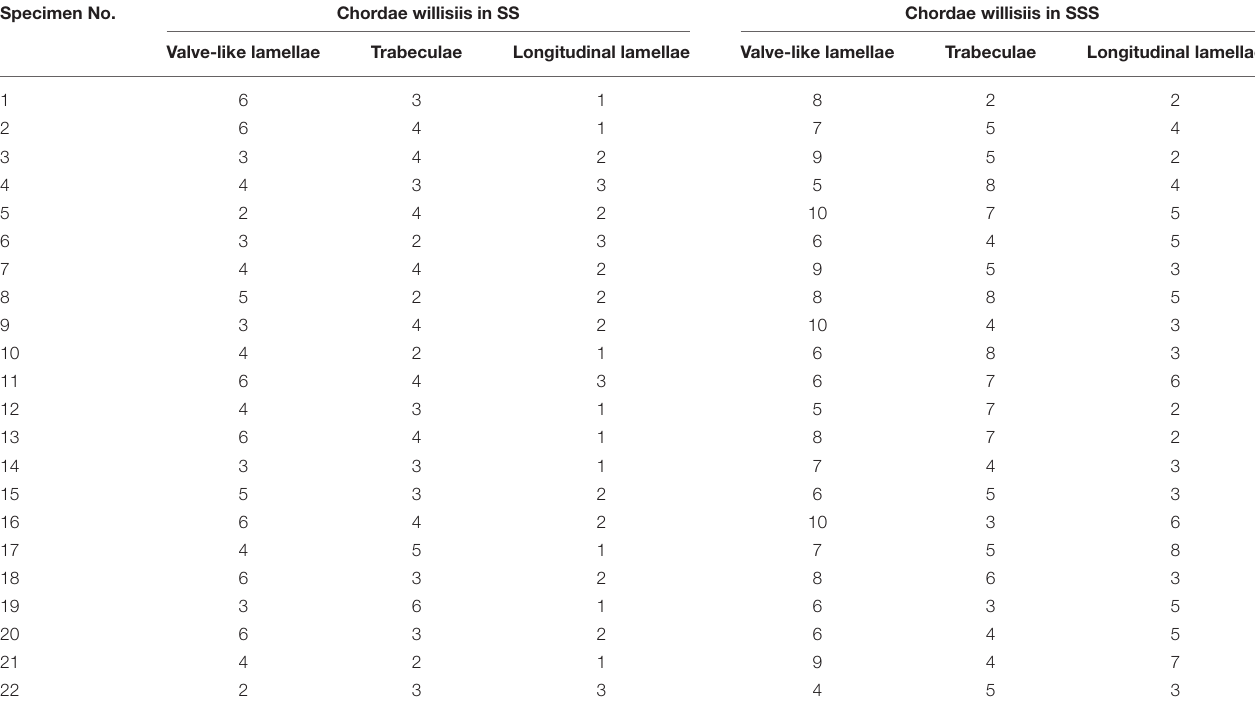
TABLE 2 | Findings in 22 cadaveric heads specimens*. Specimen No.